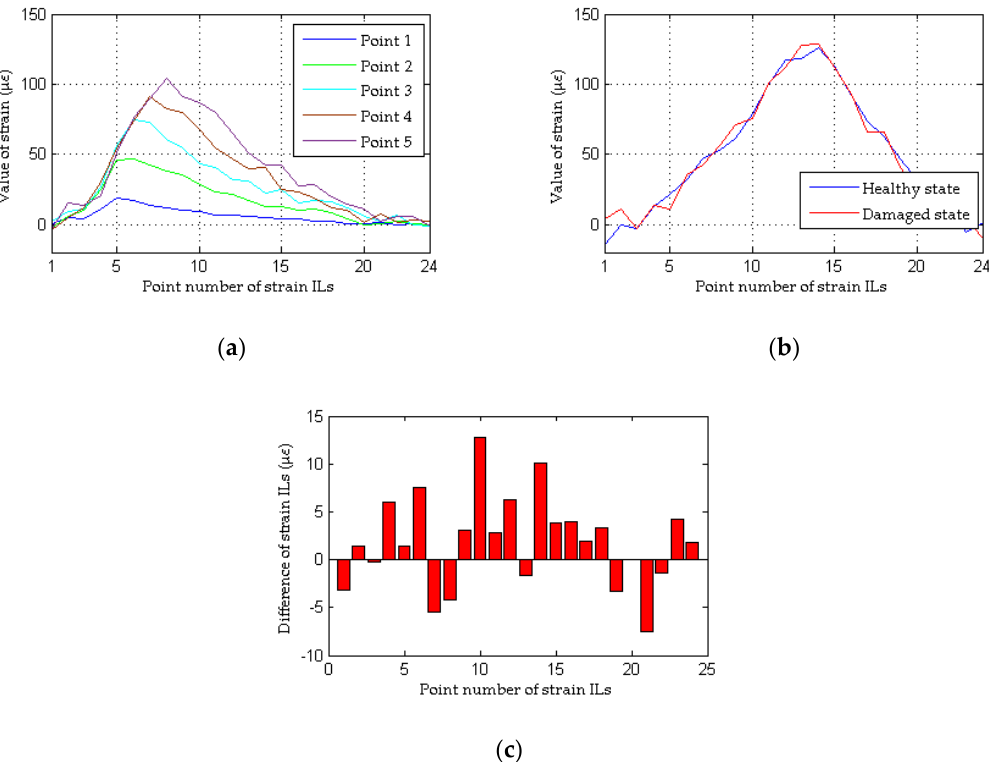
Figure 19. Results of the traditional method for the model bridge: ( a ) strain ILs of the first five measured points of the #1 beam for experimental case 1; ( b ) strain ILs at point #13 of the #1 beam for experimental case 1 and experimental case 2; ( c ) difference in the strain ILs at point #13 before and after damage for experimental case 2.